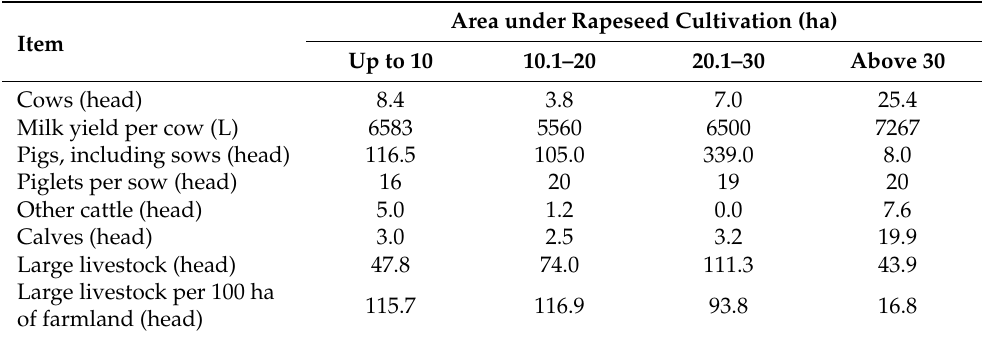
Table 3. Livestock production and area under rapeseed cultivation in the analyzed